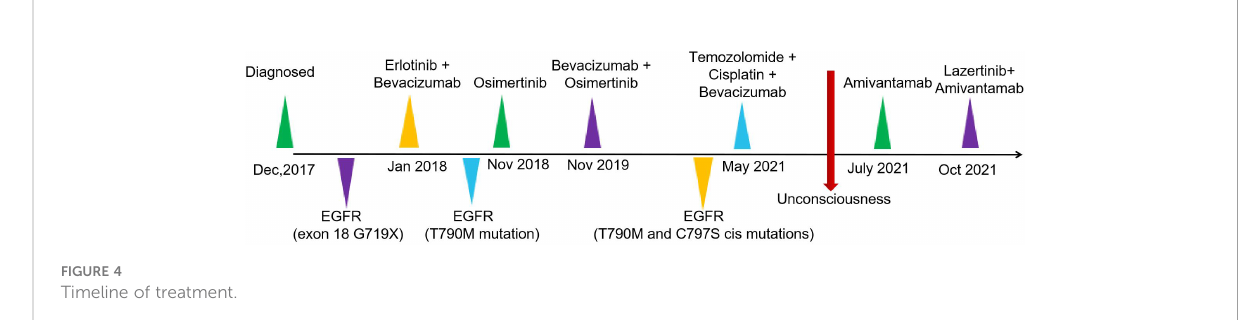
FIGURE 4 Timeline of treatment.